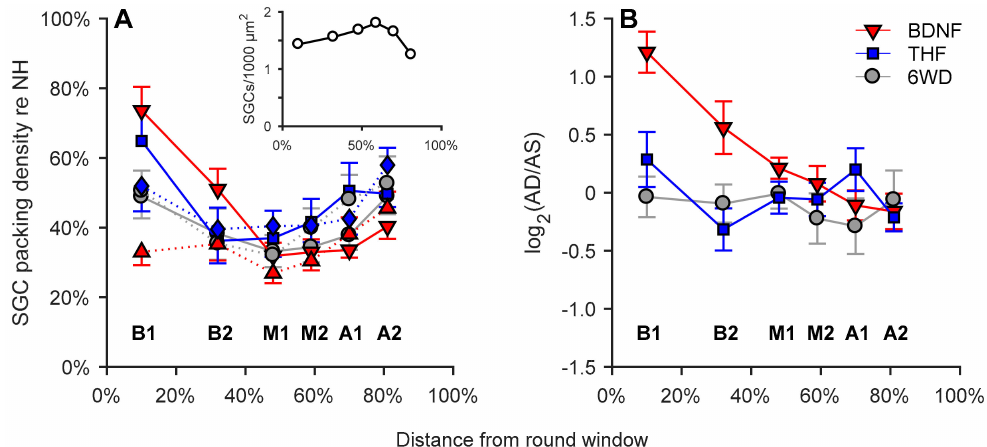
Figure 6. Normalized SGC packing density as a function of cochlear location in relative distance from the round window, in which 0% is the round window and 100% is the helicotrema. ( A ) Group means of SGC packing density plotted separately for right treated ears (AD, solid lines) and left untreated ears (AS, dashed lines). BDNF AD = down-pointing triangle; BDNF AS = up-pointing triangle; THF AD = square; THF AS = diamond. ( B ) Log transformed SGC packing density ratio AD / AS. NH, n = 6; 6WD, n = 13 BDNF, n = 12; THF, n = 11. B1 to A2 represent the cochlear locations from base to apex. Error bars represent